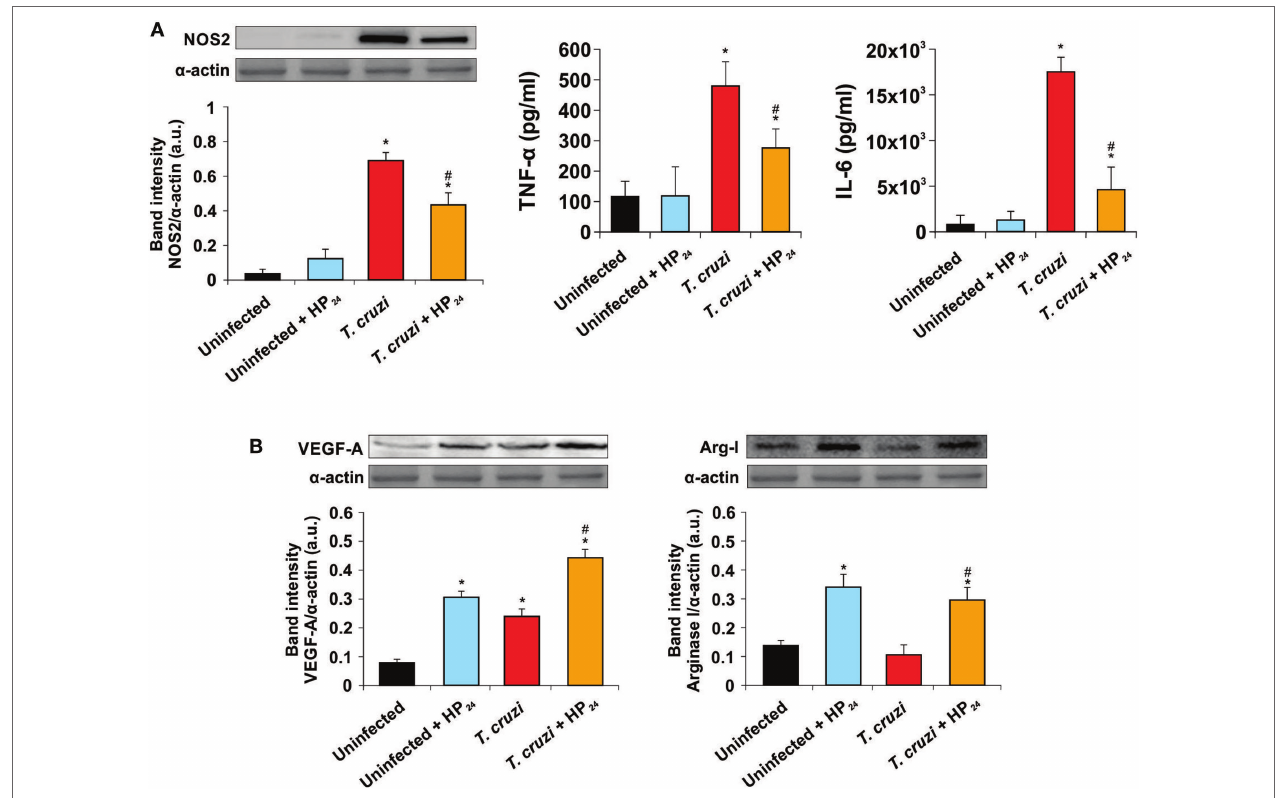
FigUre 3 | Effect of HP 24 on Trypanosoma cruzi -infected macrophages. (a) Nitric oxide synthase 2 (NOS2) expression was determined by Western blot with a specific antibody. The release of TNF- α and interleukin 6 (IL-6) to the culture medium was quantitated by capture enzyme-linked immunosorbent assays. (B) Peritoneal macrophages were obtained from uninfected, uninfected HP 24 -treated, T. cruzi -infected, and T. cruzi -infected HP 24 -treated mice at 10 dpi. Vascular endothelial growth factor A (VEGF-A) and Arginase I expressions were determined by Western blot with a specific antibody. Protein levels were normalized against α -actin. Results represent the mean ± SEM band intensity of three independent experiments (five mice per group). * P < 0.05 vs. uninfected mice, # P < 0.05 vs. T. cruzi -infected